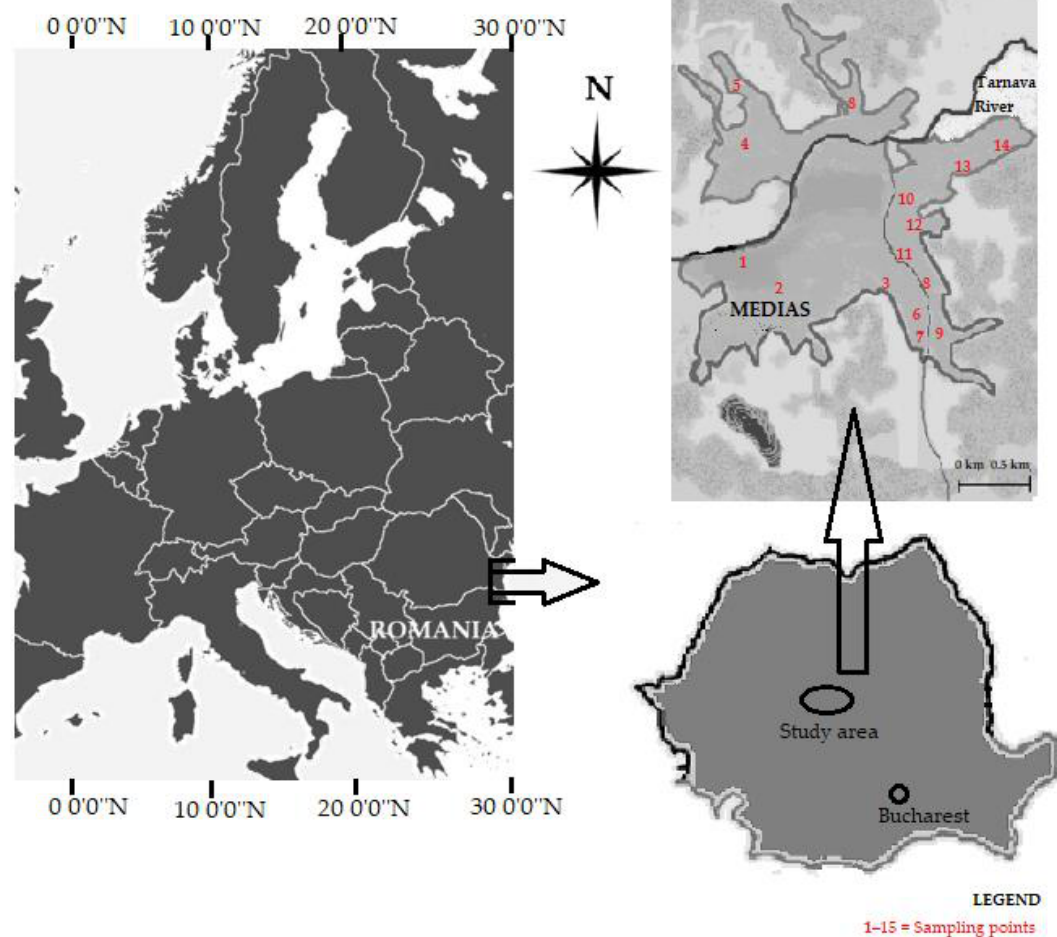
Figure 1. Location of the study area at European and national levels.